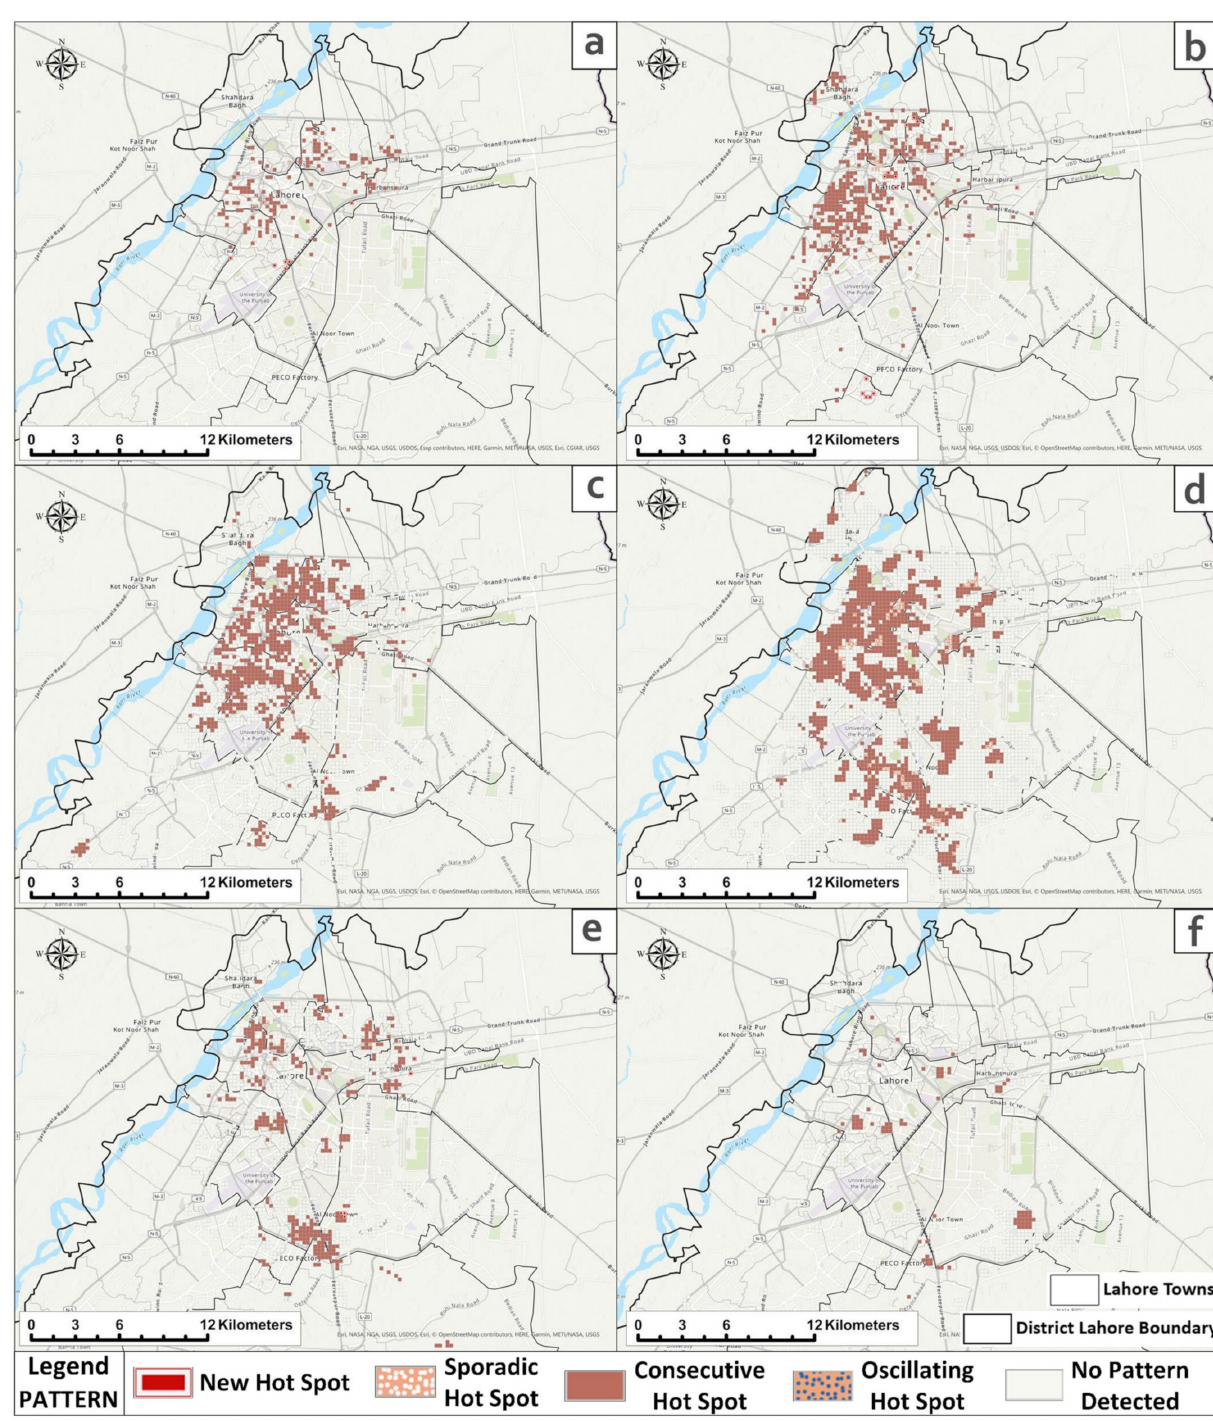
Figure 9. Space–time hot spots of DF using the Emerging Hot Spot Analysis : ( a ) 2007, ( b ) 2008, ( c ) 2010, ( d ) 2011, ( e ) 2013, ( f )